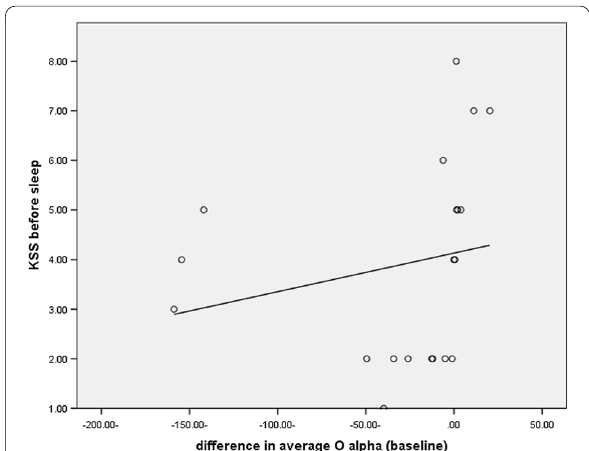
Fig. 2 Positive significant correlation between the difference of EEG (Average Occipital O alpha) before and after sleep with KSS before sleep in the cases. ( P =